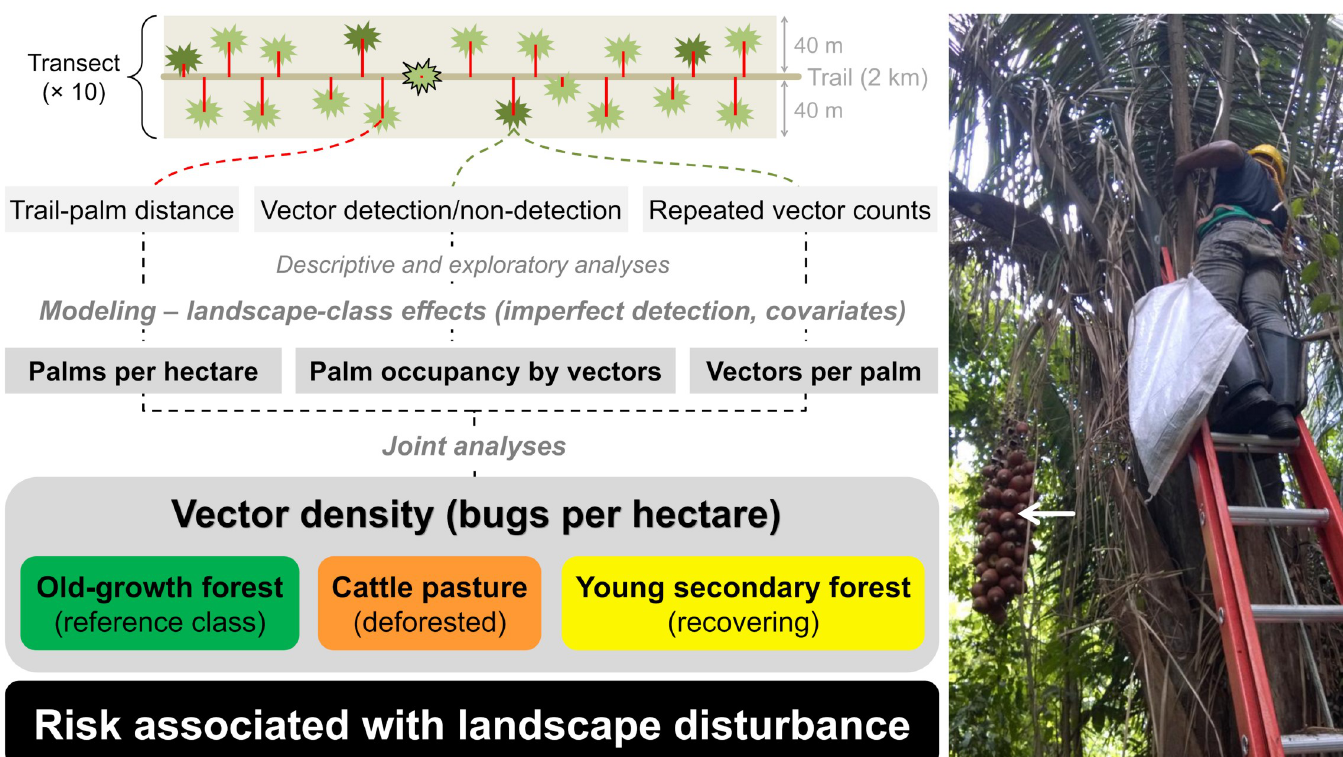
Fig 1. Field-sampling design, main data features, and data-analytical strategy. We sampled 10 transects by walking a central trail and measuring the perpendicular distance (red lines) between each adult Attalea palm seen (green star-like shapes) and the center of the trail. Palm detection was assumed certain for palms at zero distance (black-outlined palm). A systematic sample of evenly-spaced palms (darker green) was selected for triatomine-bug sampling in each transect. The right-hand-side picture illustrates bug searches, which included one direct catch on the palm plus a second, independent catch in palm debris collected in a bag; the white arrow points to a palm- fruit cluster. Palm-trail distances, bug detections/non-detections and repeated bug counts were used for descriptive/exploratory analyses and for inferential statistical modeling–in which we estimated covariate-adjusted landscape-disturbance effects after taking palm and bug detection failures into account. Joint analyses of palm and bug density allowed us to derive estimates of bug density per unit area in three landscape classes–old-growth forest, cattle pasture, and young secondary forest. We thus were able to make inferences about whether and how anthropogenic landscape disturbance is associated with three putative proxies for Chagas disease risk–palm density, palm infestation, and vector